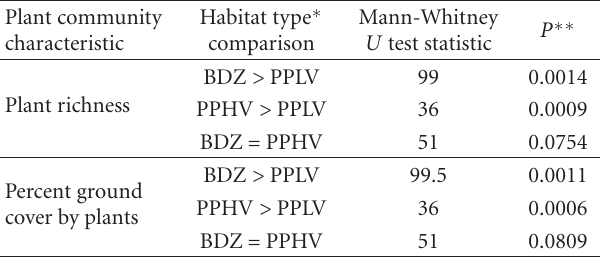
Table 7: Mann-Whitney U tests comparing plant community characteristics between habitat types at Mount St. Helens National Volcanic Monument.